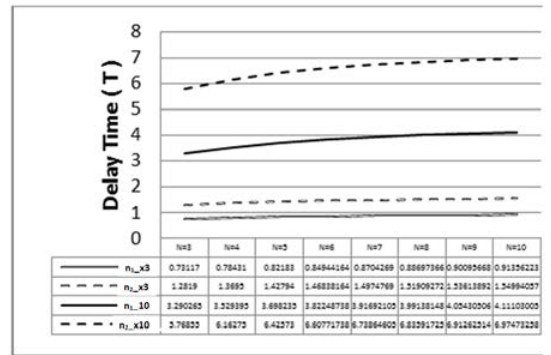
Figure 11: The delay time with numerous sensor